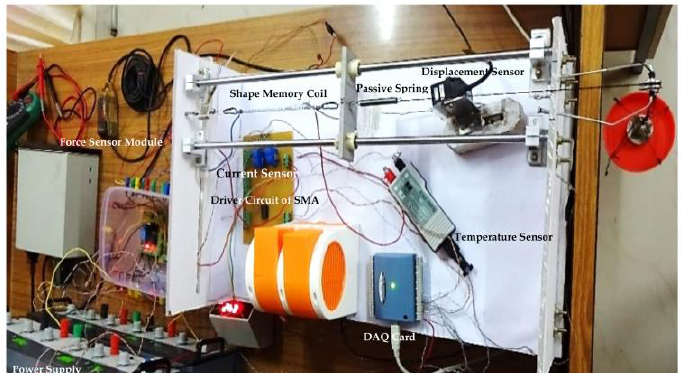
Figure 1. Experimental setup. Table 1. Technical specifications of the passive steel spring.